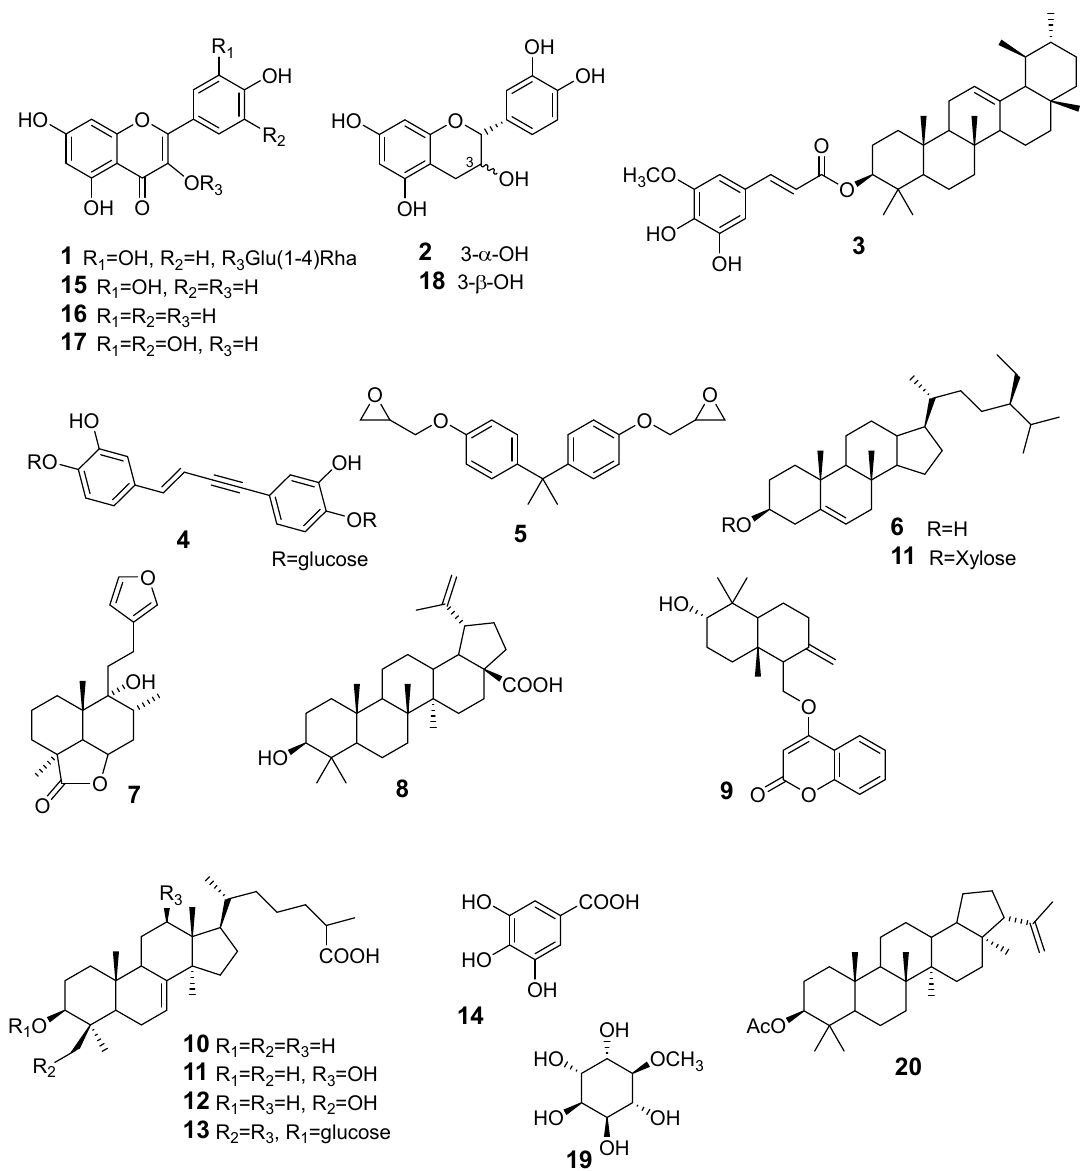
Figure 2. Antidiabetic compounds isolated from Eastern Cape antidiabetic medicinal plants. The numbers 1–20 correspond to the compounds reported in Table 2.